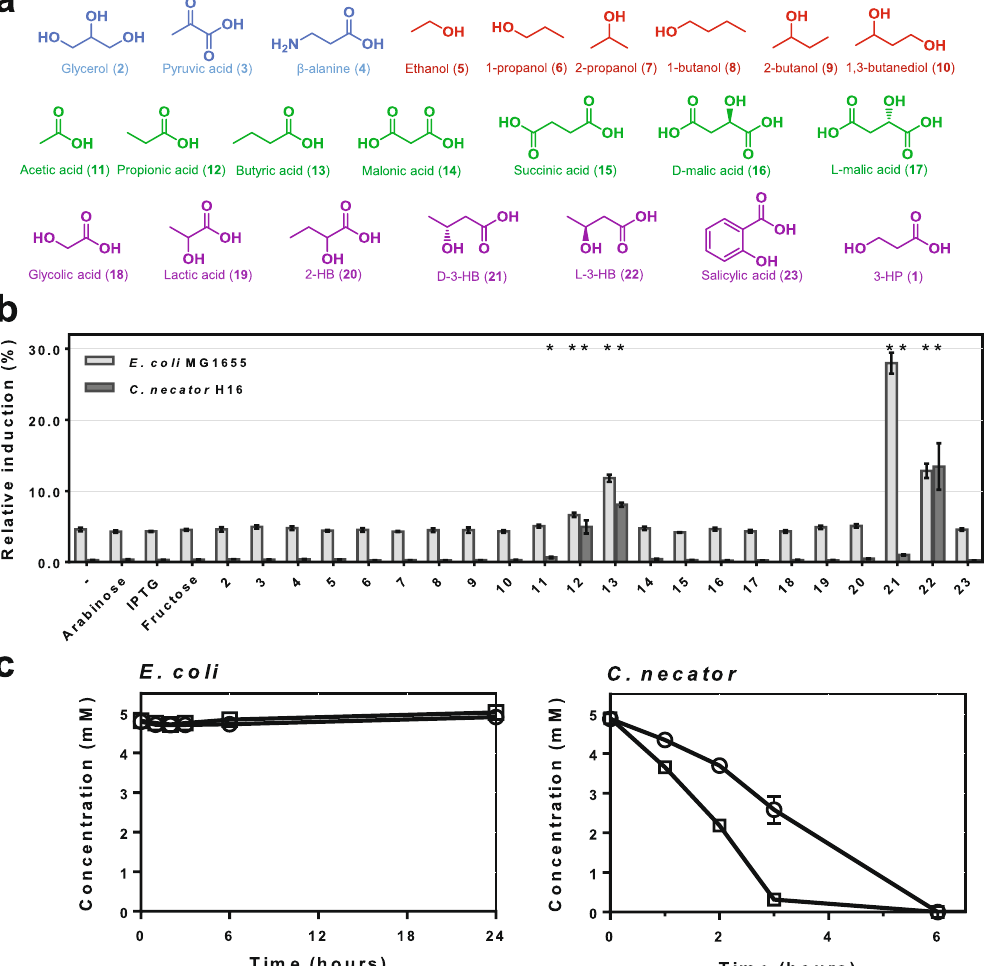
(3), β -alanine (4), ethanol (5), 1-propanol (6), 2-propanol (7), 1-butanol (8), 2-butanol (9), 1,3-butanediol (10), acetic acid (11), propionic acid (12), butyric acid (13), malonic acid (14), succinic acid (15), D-malic acid (16), L-malic acid (17), glycolic acid (18), lactic acid (19), 2-hydroxybutyric acid (20), D-3-hydroxybutyric acid (21), L-3-hydroxybutyric acid (22) and salicylic acid (23). ( b ) Relative induction levels of the Pp HpdR/P hpdH switchable system which was subjected to a variety of putative TIMs. The various compounds were tested in E. coli MG1655 (light grey) and C. necator H16 (dark grey) harbouring pEH008. Error bars represent standard deviations of three biological replicates. Asterisks indicate statistically significant induction values for p < 0.01 (unpaired t test). ( c ) Consumption of D- (21, square) and L-3-HB (22, circle) in E. coli MG1655 and C. necator H16. Error bars represent standard deviations of three biological